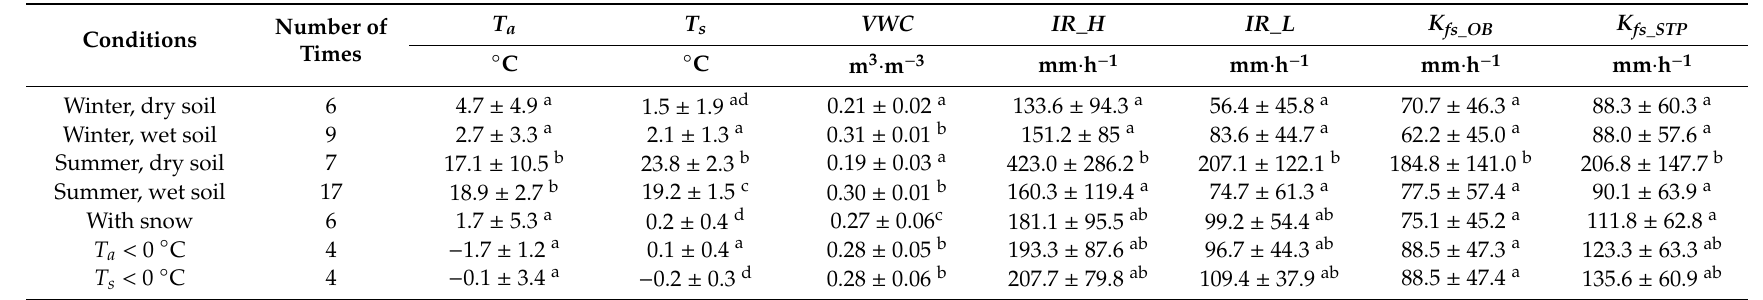
Table 4. Characteristics of infiltration processes under di ff erent conditions. T a is air temperature, T s is soil temperature, and VWC is initial soil volumetric water content. IR_H and IR_L are the infiltration rates measured at high and low pressure heads, respectively; K fs_OB and K fs_STP are the initial observed and viscosity-corrected field-saturated hydraulic conductivities, respectively. Di ff erent letters in the same column indicate significance groupings at α =